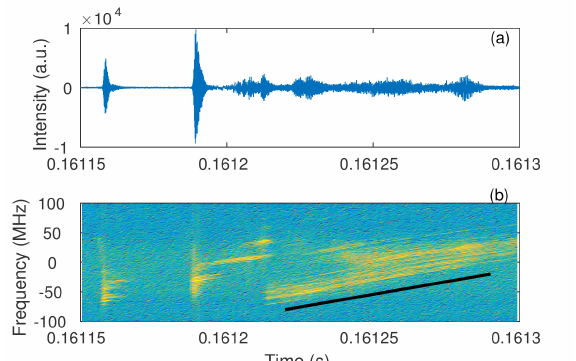
Figure 6: The results for a group of ω pe bursts measured by the real-time spectrum analyzer: (a) raw data, (b) spec- trogram obtained using FFT, and the black solid line indi- cates a sweeping rate of 0.86 MHz / µ s. The frequency of the emission is the summation of the frequency illustrated in the figure, the carrier wave frequency of the real-time spectrum analyzer (7.5 GHz), and the LO frequency of the radiometer (34 GHz).